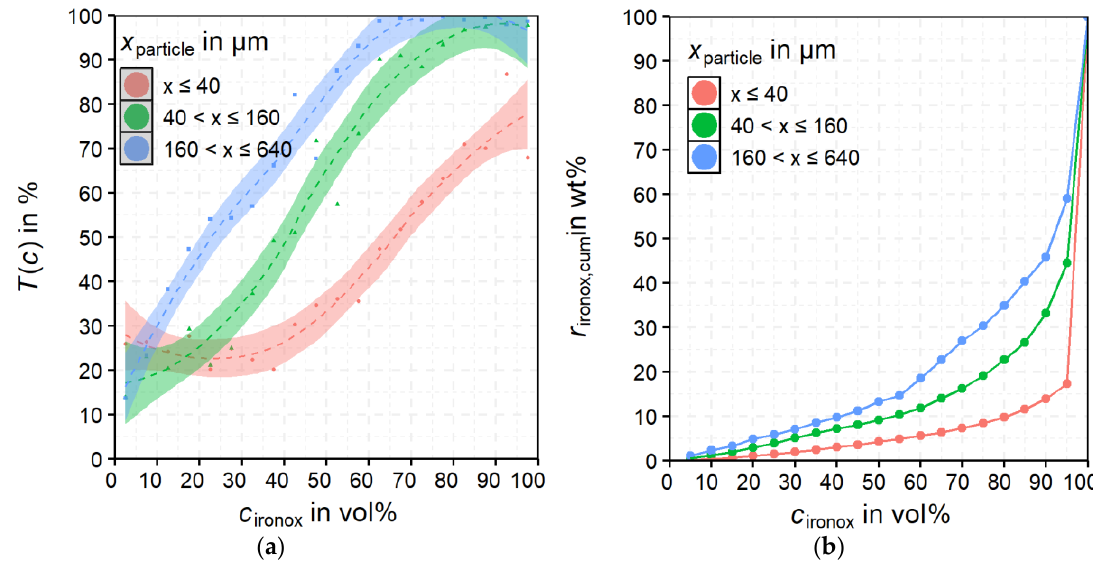
Figure 6. T ( c ) vs. c ironox ( a ) for three different particle size classes; ( b ) cumulative distribution of iron oxides ( r ironox,cum ) in the content classes ( c ironox ) of the feed material for three different particle size classes.